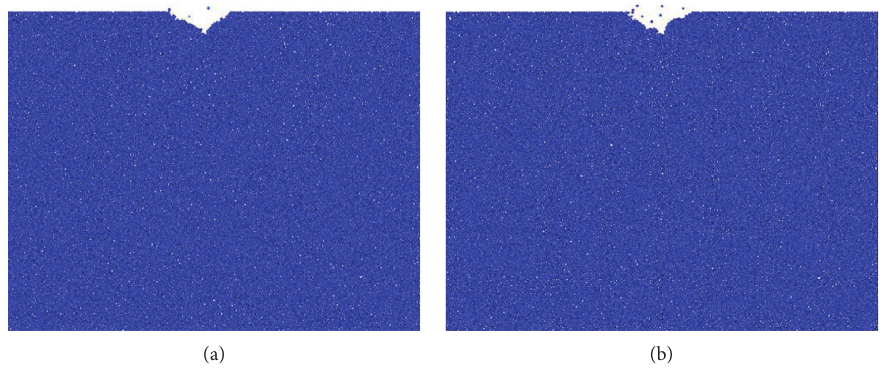
Figure 14: Blasting crater caused by different charge quantity: (a) 60g and (b) 80 g.